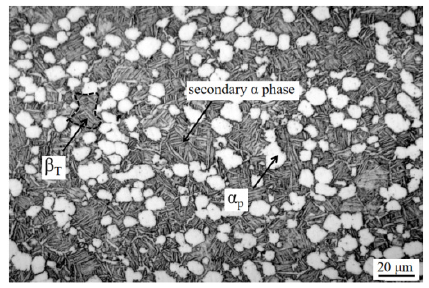
Figure 2. Original microstructure of TC10 alloy bars.